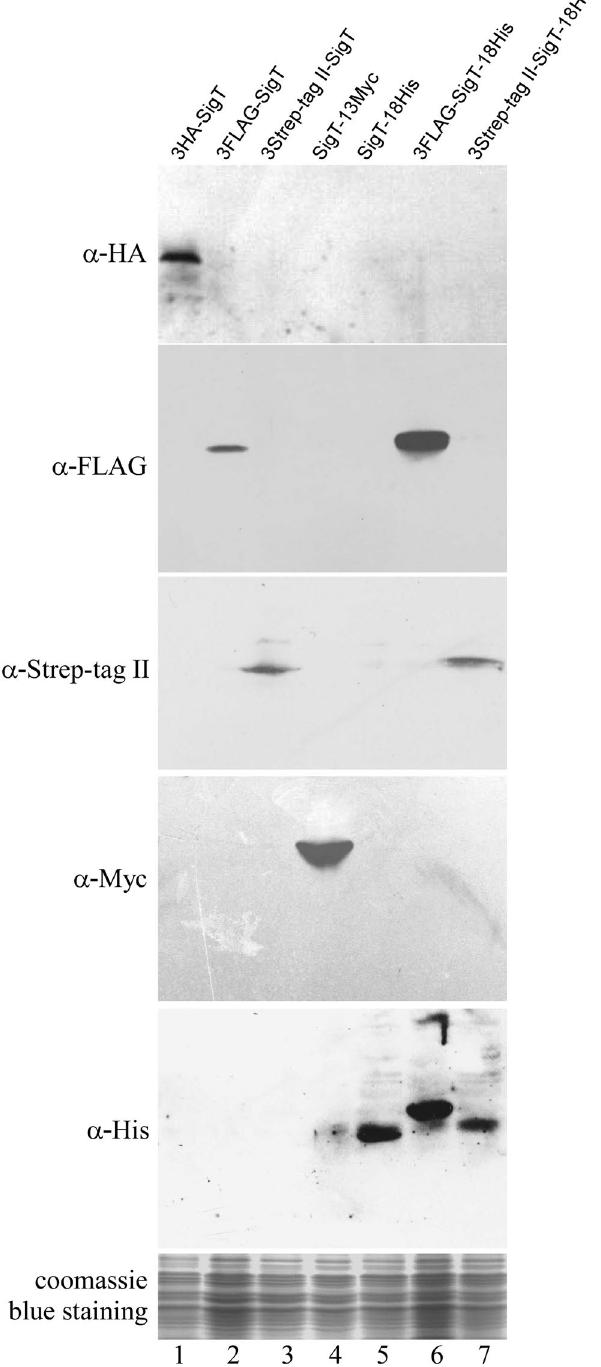
Figure 2. Western blot analysis of expression of SigT fused with series affinity tags in S. coelicolor M145 from pSN2-pSN8. All samples were immuno-blotted with tag-specific antibodies, and coomassie blue staining of total protein served as a loading